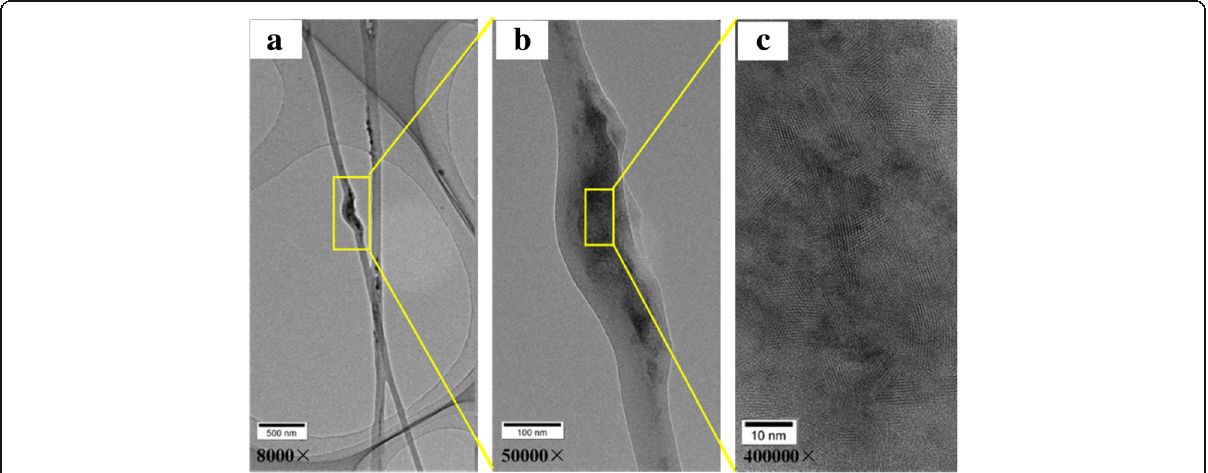
Fig. 6 TEM images of PA66/CoCl 2 ·6H 2 O (50 wt%) fibers: a magnified 8000 times and b magnified 50000 times. c HRTEM image of cobalt chloride particles